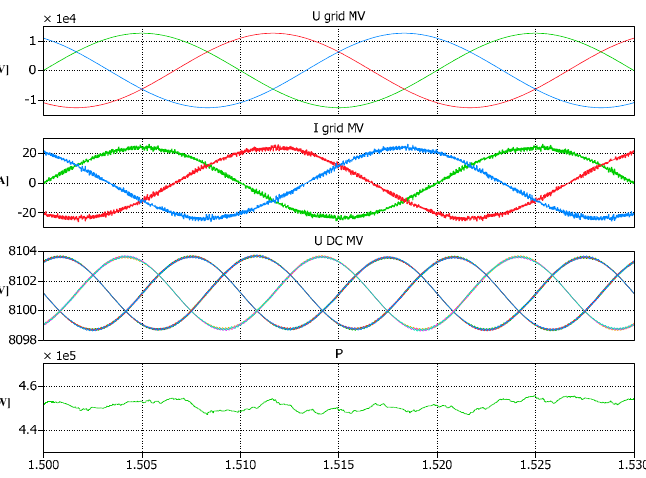
currents are sinusoidal and in phase with line voltages. DC voltages in nine H-bridges are balanced, and their voltage fluctuation does not exceed 0.6% of the whole voltage. The MV grid active power is constant.